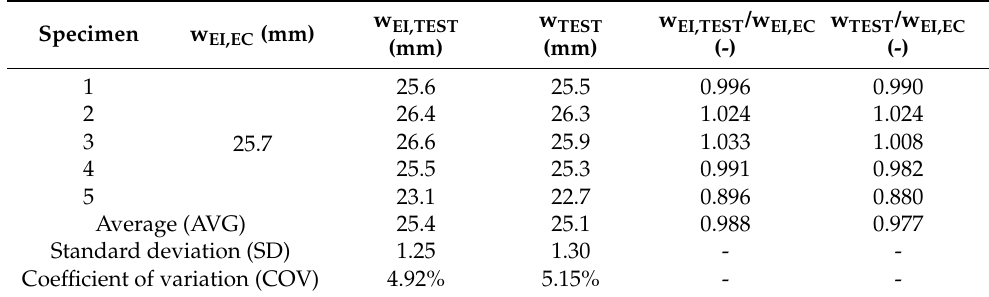
Table 7. Results of the maximum deflections at the mid-span corresponding to 40% of the estimated maximum force for CLT